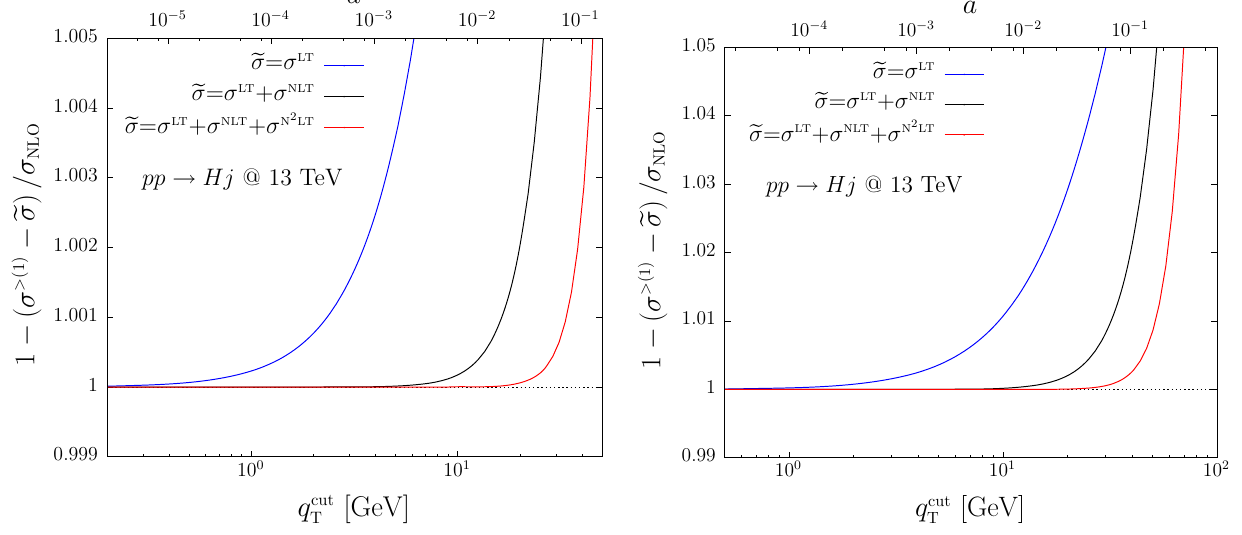
(cid:9) (cid:10) σ >( 1 ) − ! σ /σ NLO as a function of q region is displayed, while, in the right pane, a T